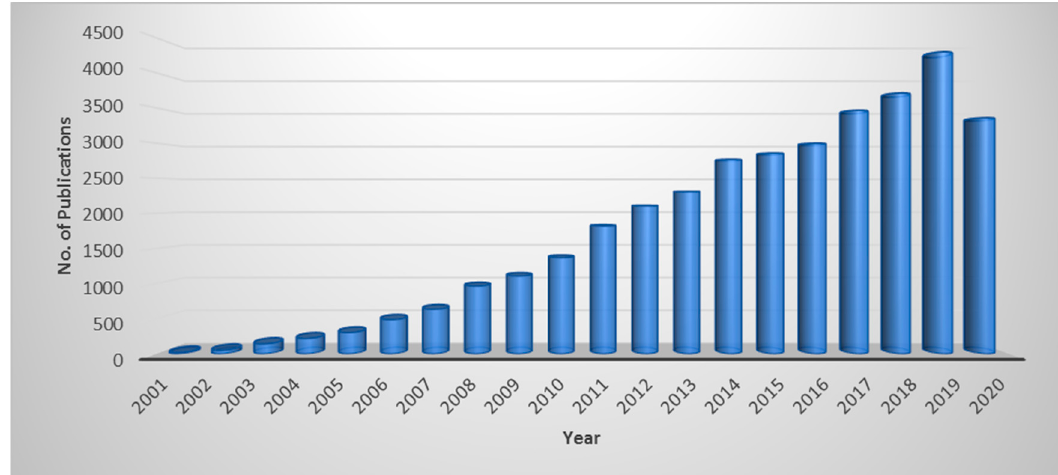
Figure 14. Formation of a Taylor cone with the increase of applied voltage.